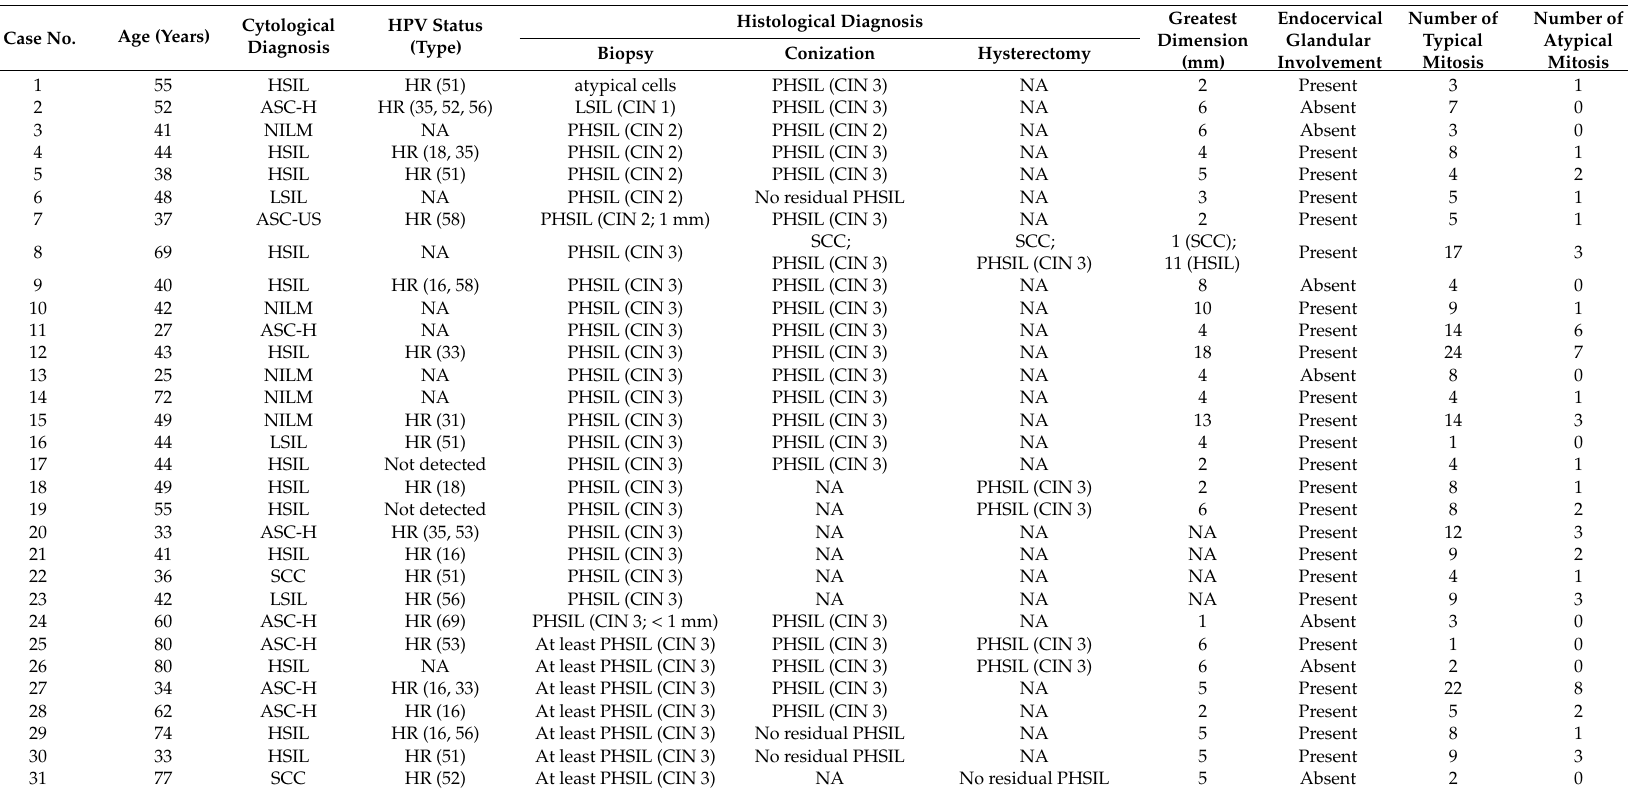
Table 1. Clinicopathological characteristics of 31 patients with pleomorphic high-grade squamous intraepithelial lesion (PHSIL). Case